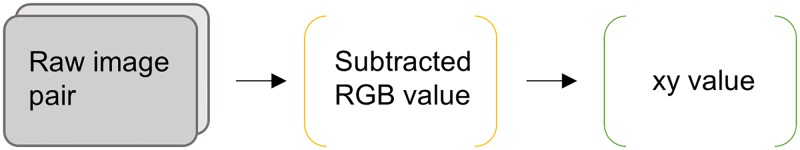
Data analysis pipeline.An image pair of the colorimetric subject is captured. The subtracted RGB value for the particular region of interest is then calculated by subtracting the median RGB values for each image. The previously calculated RGB to XYZ mapping (M) is then applied and xy chromaticity values are calculated, yielding device and ambient light independent color values.